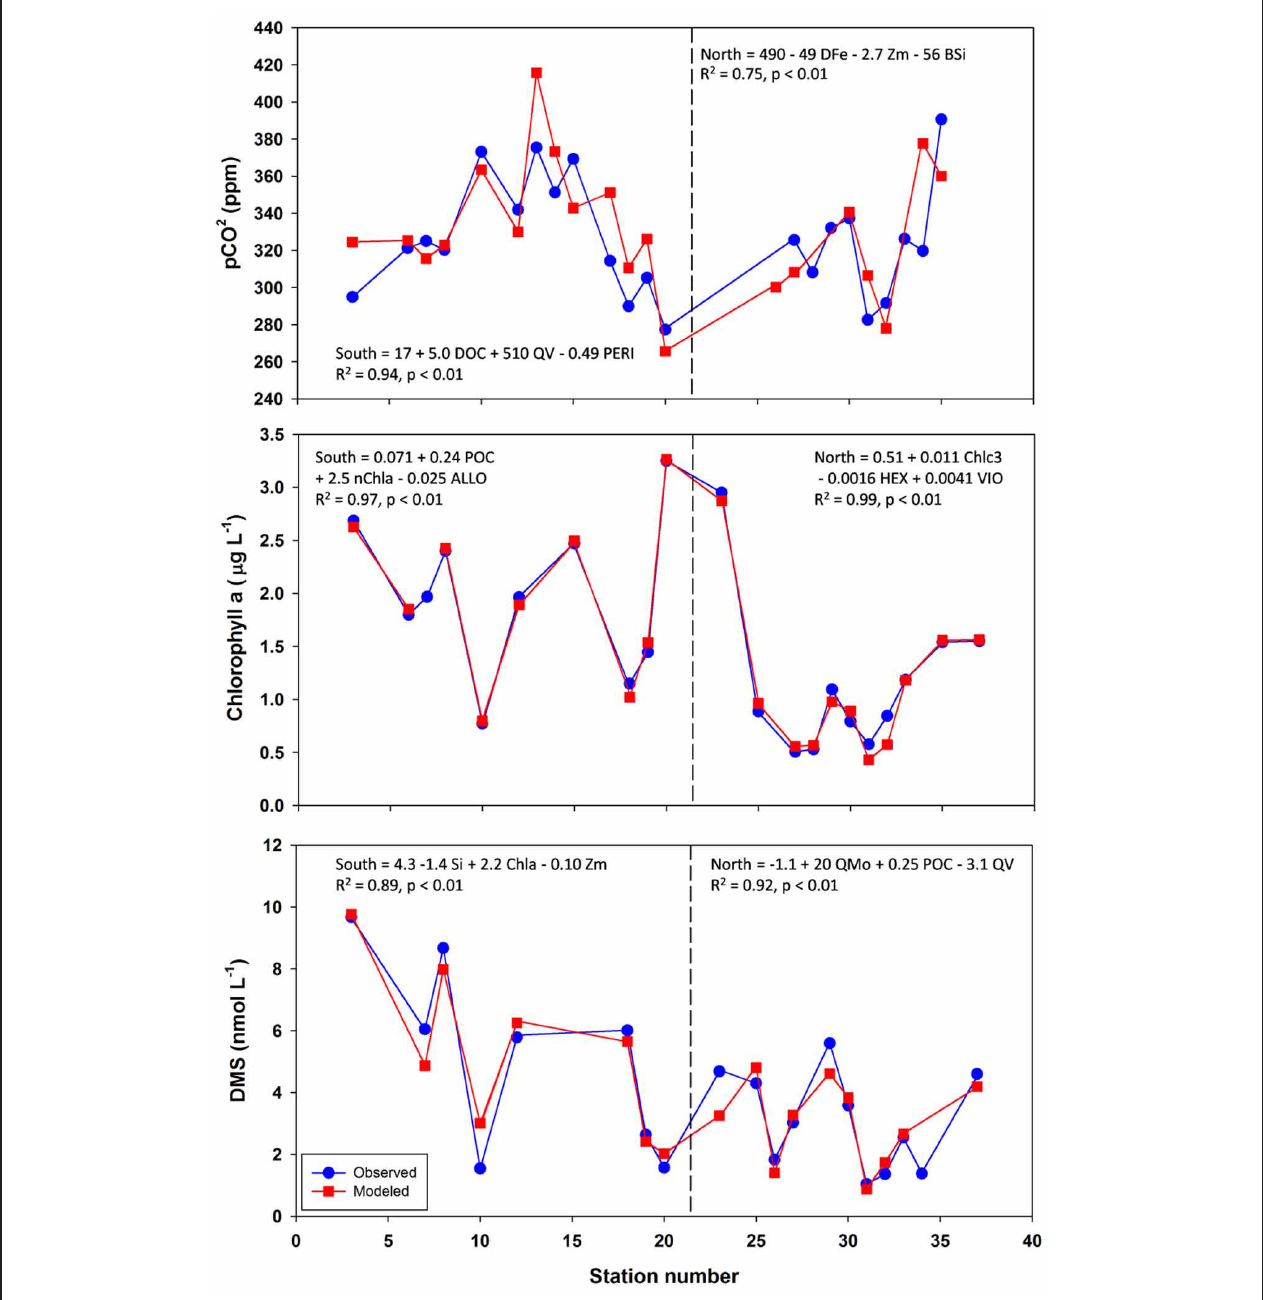
are given for each regression. Vertical dashed line separates the Southern (left panel, stations 1–23) from Northern transect (right panel, stations 24–37)